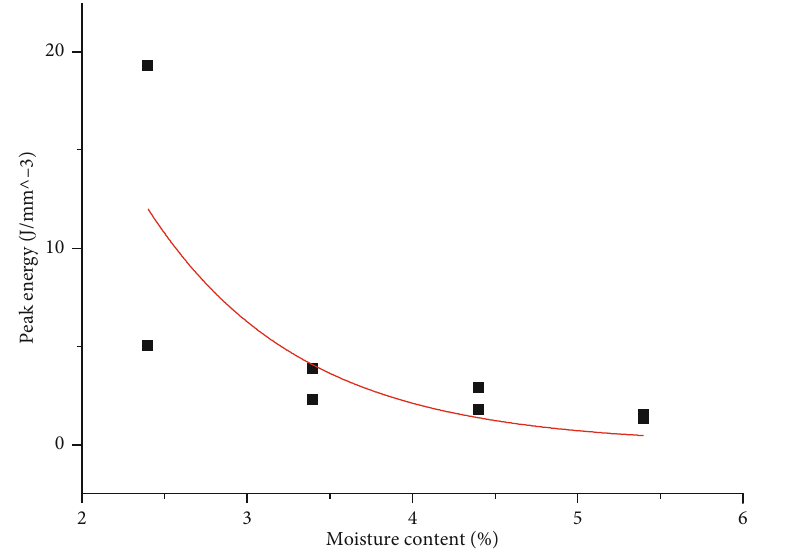
Figure 12: Water content-peak energy evolution diagram of coal.